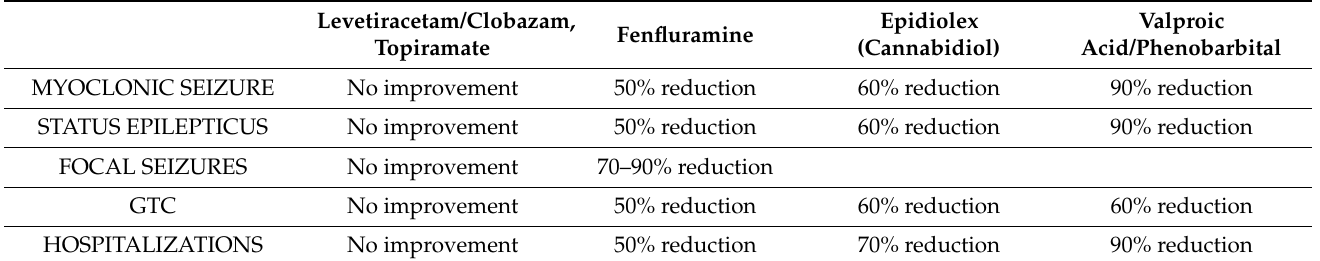
Table 1. Clinical response to anti-seizure